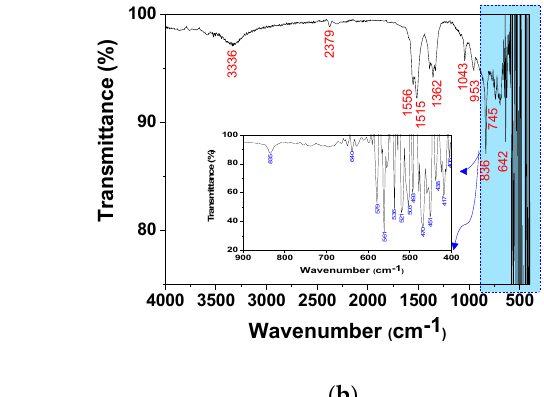
Table 1. Structural characteristics of Ni/Zn based bi-phase nanohybrid. Phase